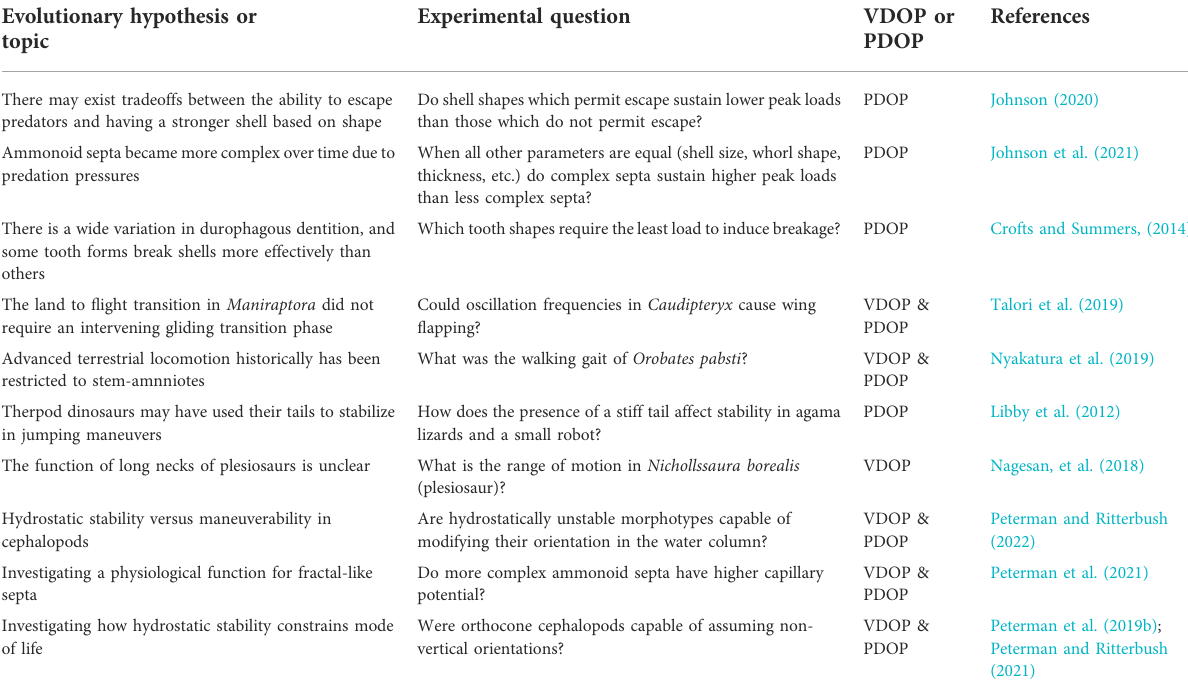
TABLE 1 Examples of macroevolutionary hypotheses and topics that have been addressed using DOPs. Each topic must be narrowed to an appropriate scope for an experimental question before a VDOP or PDOP can be